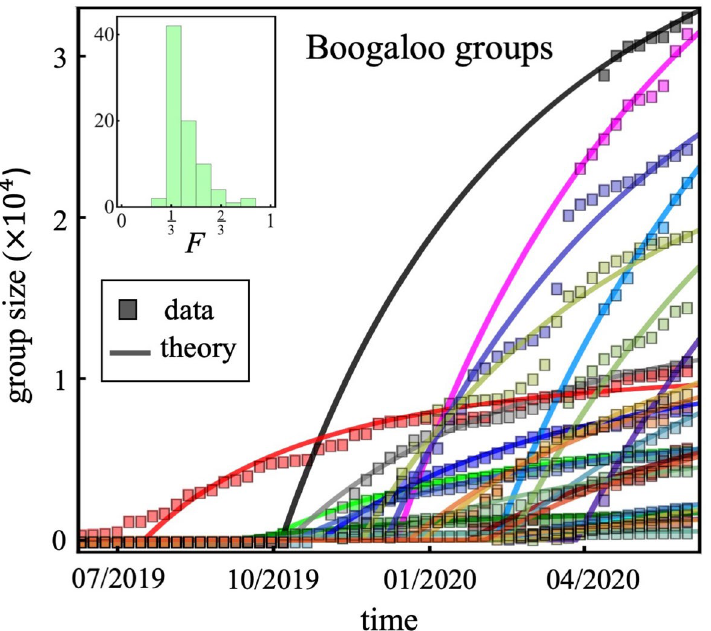
Figure 1. Growth curves of online Boogaloo groups. Each color/curve represents a Facebook Page that is a Boogaloo group, the size of which is the number of online members. Their empirical growths (symbols) differ and occur over different timescales. The solid lines show different allowed solutions of the same mathematical equation that incorporates individual user heterogeneity into the online social aggregation process (see Supplementary Information (SI) Eq. (21), with full derivation shown in SI Sect. 2). For visual clarity, only a few of the groups are shown in the main plots.